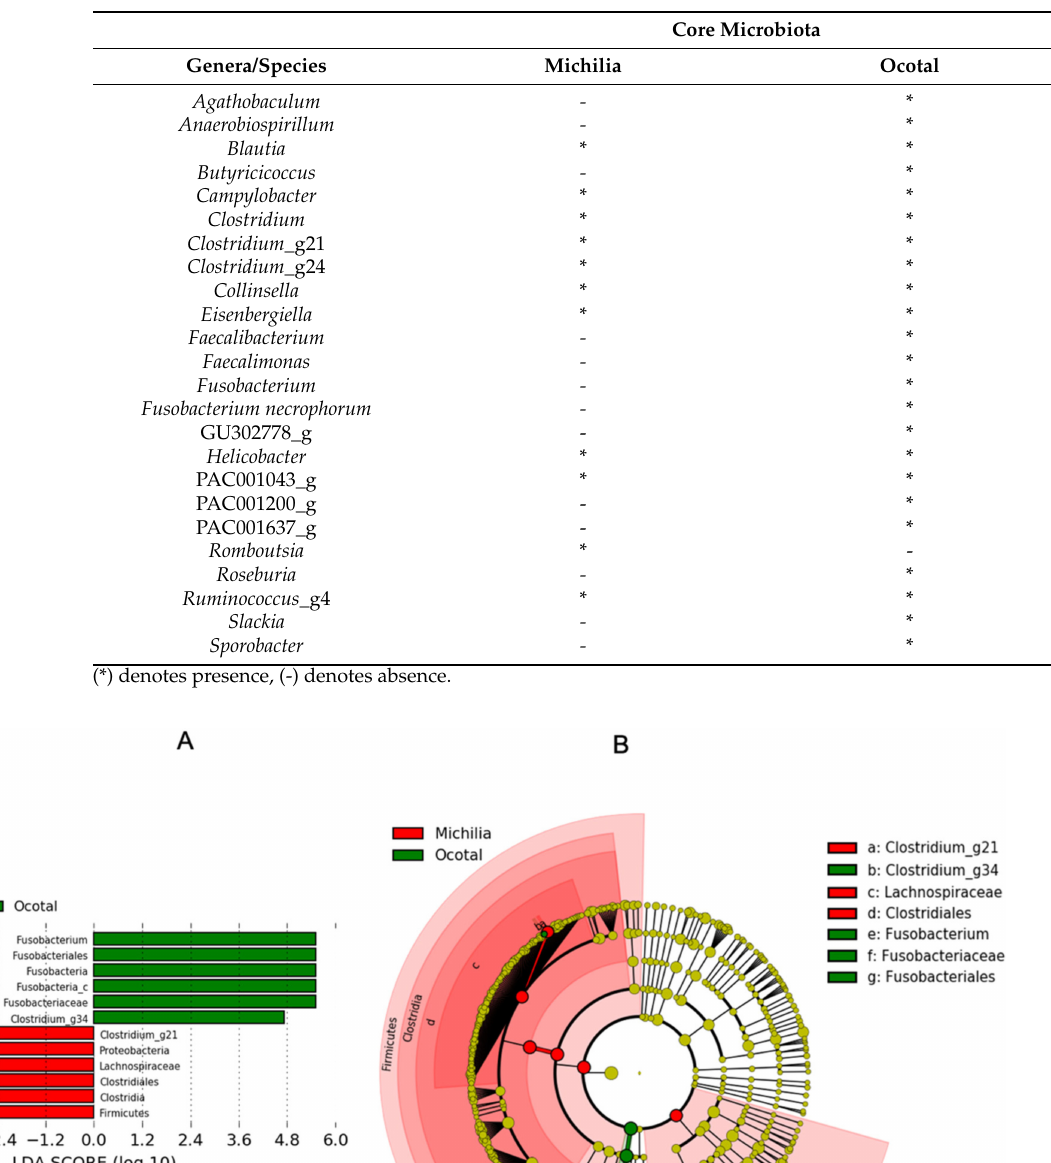
Table 4. Core fecal bacterial microbiota (taxa that were found in all individuals) from two populations